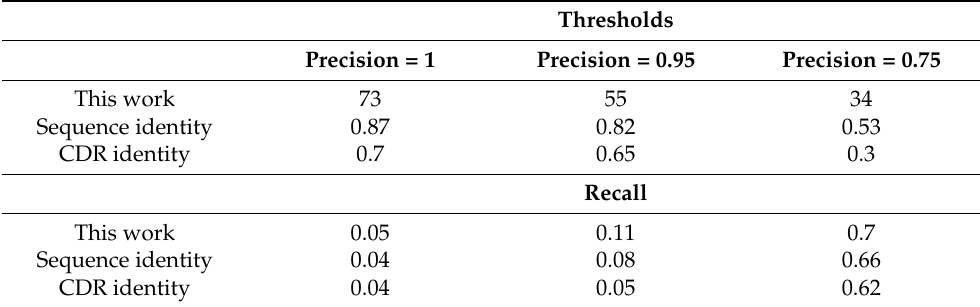
Table 1. Recall values corresponding to fixed precision values for similarity score, sequence identity, and CDR identity. Corresponding threshold values are also given. Thresholds Precision = 1 Precision = 0.95 Precision =